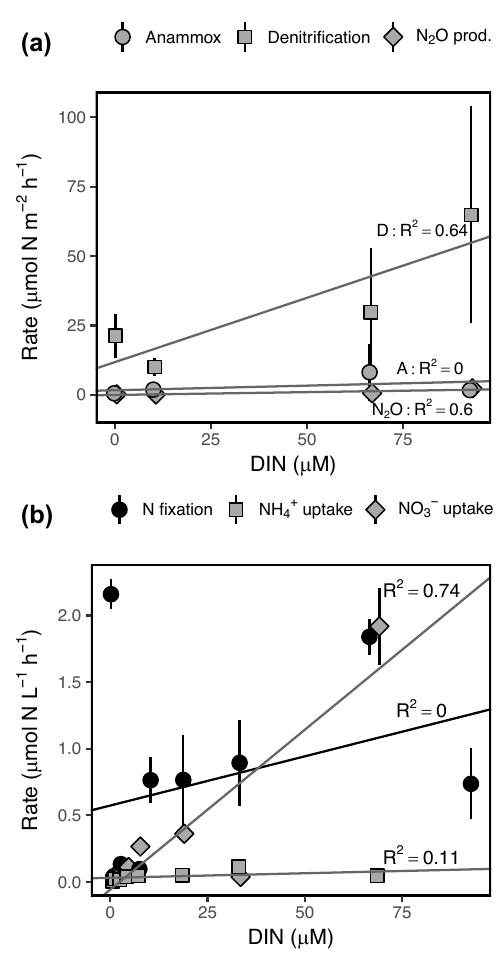
Figure 7. Rates of (a) dissimilatory and (b) assimilatory N cycling processes as a function of DIN concentration + NO − + NO − (NH + ). Note the differing y axis scales among pan- 4 3 2 els. Error bars represent ± 1SD. R 2 represents the adjusted R 2 for each linear